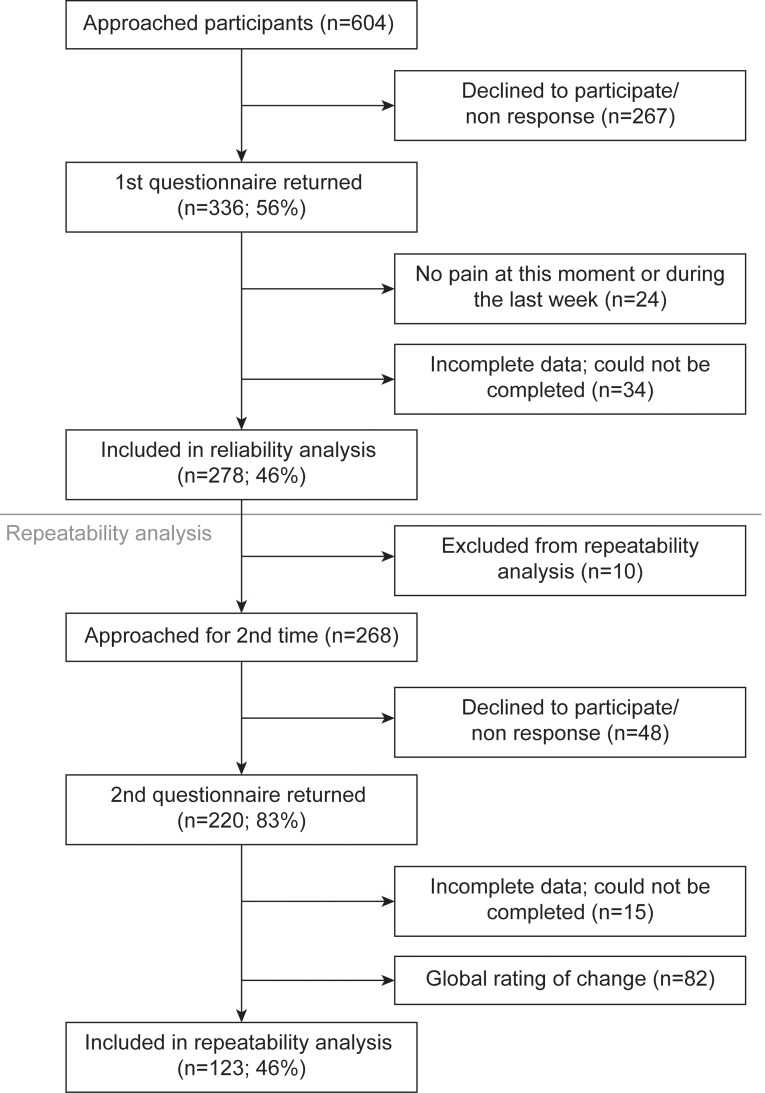
Flow chart showing inclusion procedure.